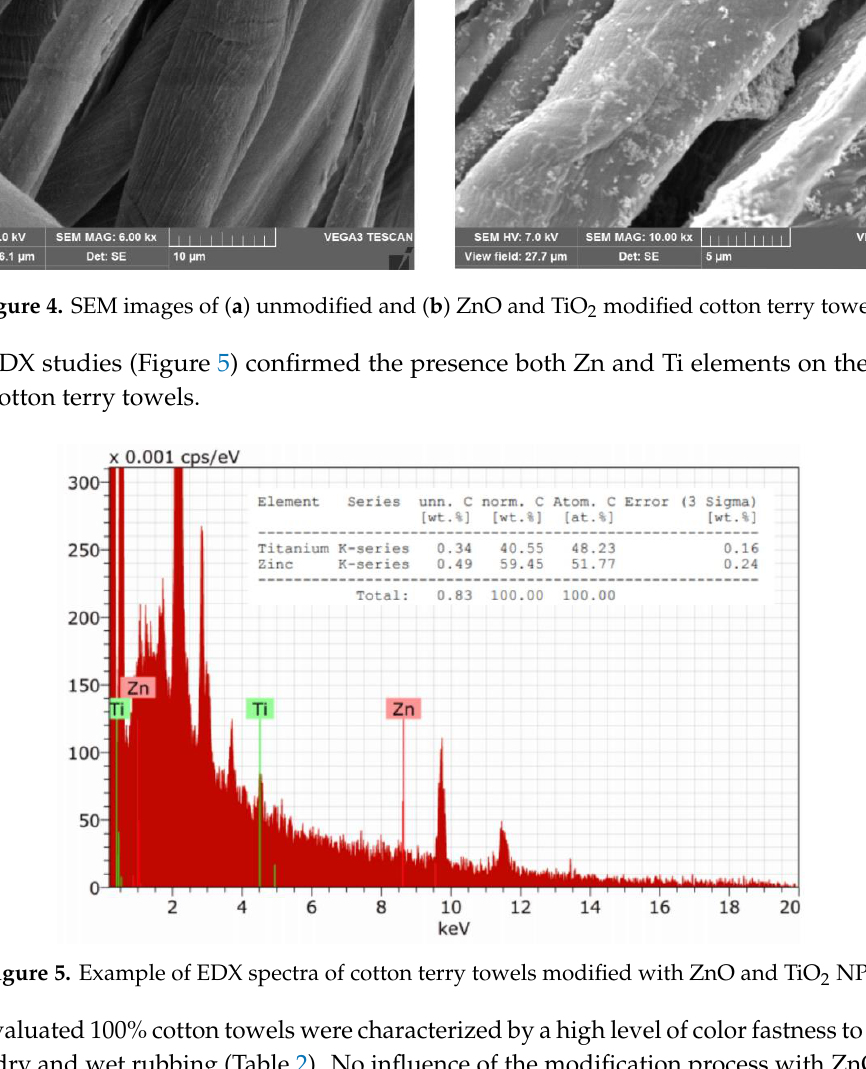
Figure 5. Example of EDX spectra of cotton terry towels modified with ZnO and TiO2 NPs.